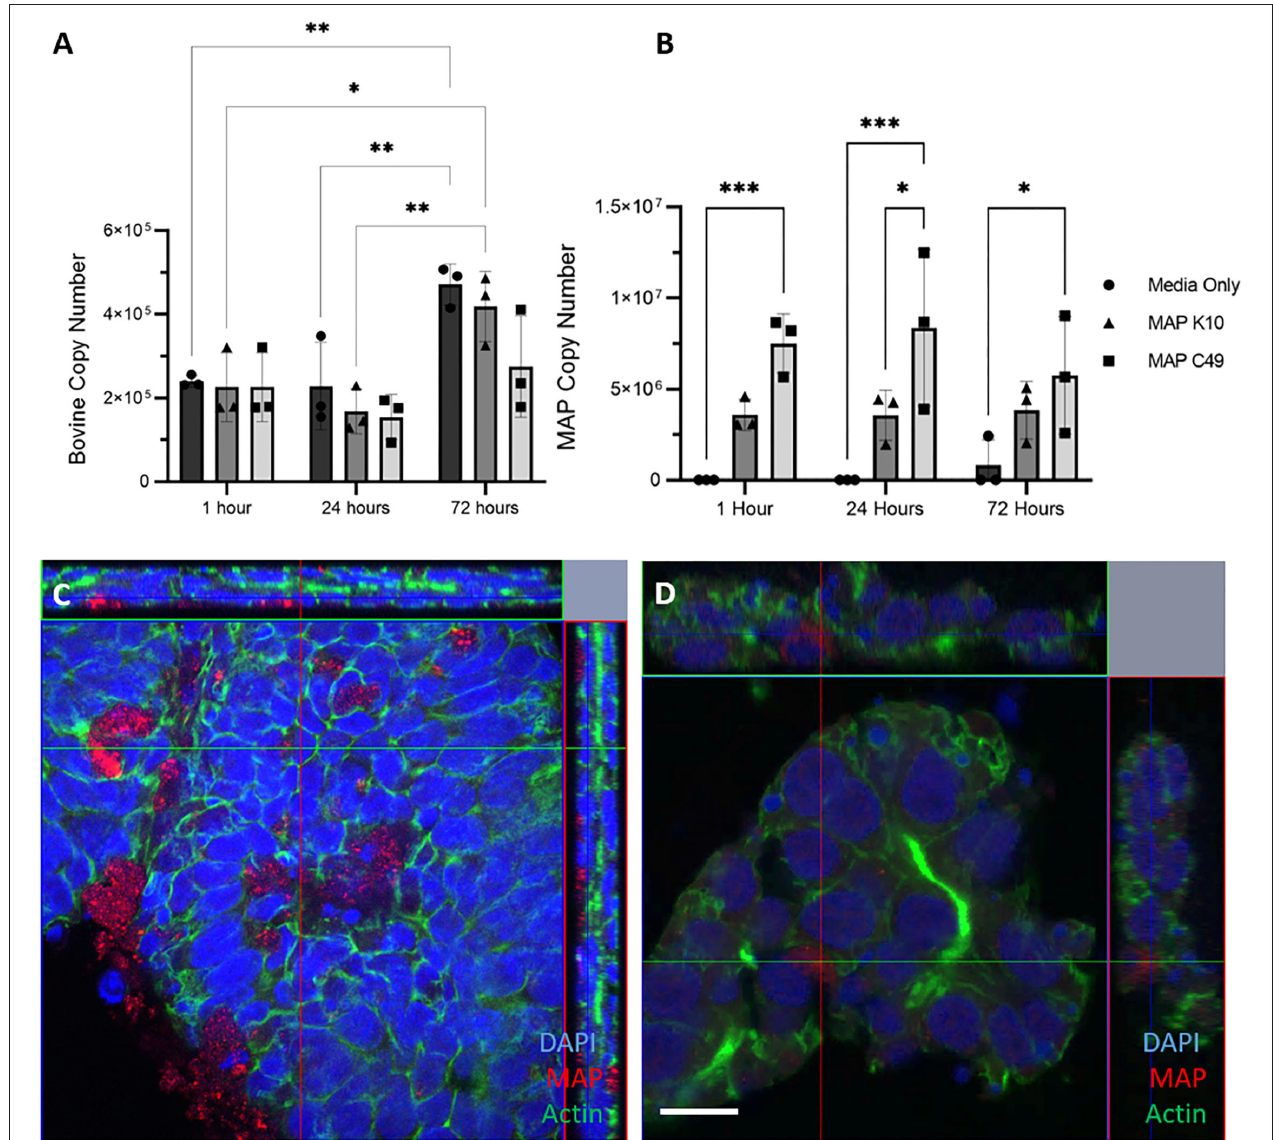
FIGURE 5 | Infection of basal-out 3D enteroids with 2 different strains of MAP. Enteroids were infected with an MOI of 100 in 3 biological replicates using enteroids generated from the same calf at passage 15, 17 and 20. The bovine (A) and bacterial (B) cell number was quantified using qPCR for the spastin gene and F57 sequence element respectively via qPCR (data presented as mean ± SD). Statistical analysis performed using 2-way ANOVA followed by a post hoc Tukey’s test. P < 0.05 = *; P < 0.01 = **; P < 0.001 = ***; P < 0.0001 = ****. (C–D) Immunofluorescence microscopy images of infected 3D enteroids 24h post infection. Enteroids were stained for nuclei (DAPI, blue), F-actin (Phalloidin, green) and MAP (anti-MAP, red). 3D enteroids are shown as a cross section from Z-stack images infected with MAP K10 (C) and MAP C49 (D) . Scale bar = 10 µ